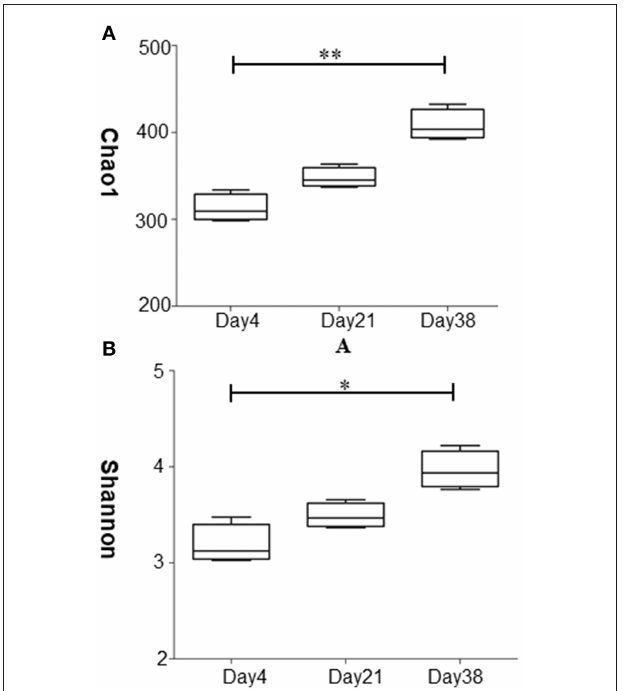
FIGURE 3 | Analysis of the diversity of fungal community at different stages in the poultry house. (A) Chao1 diversity of the fungal community. (B) Shannon diversity of the fungal community. Data are expressed as the means ± SDs, ** P < 0.01, * P < 0.05 compared between the two groups ( n = 3).